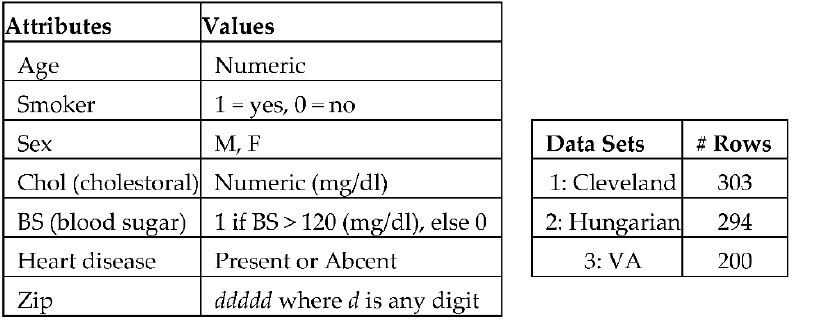
Figure 6. Summary of the Three Data Sets.